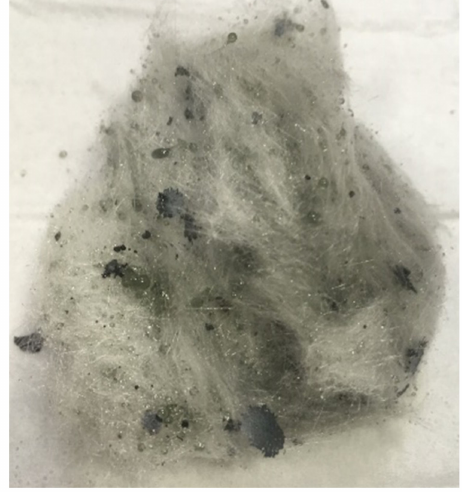
Figure 4. Sample of wool derived from white